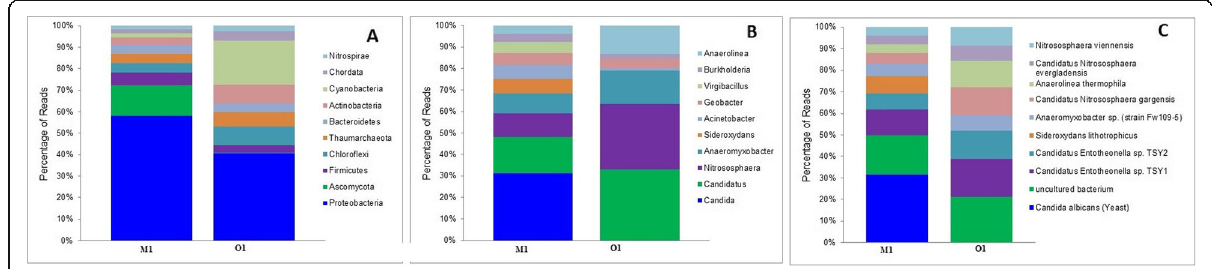
Fig. 3 Percent distribution of transcripts representing various taxonomical groups at phylum, genus, and species level in M1 and O1. a Phylum. b Genus. c Species